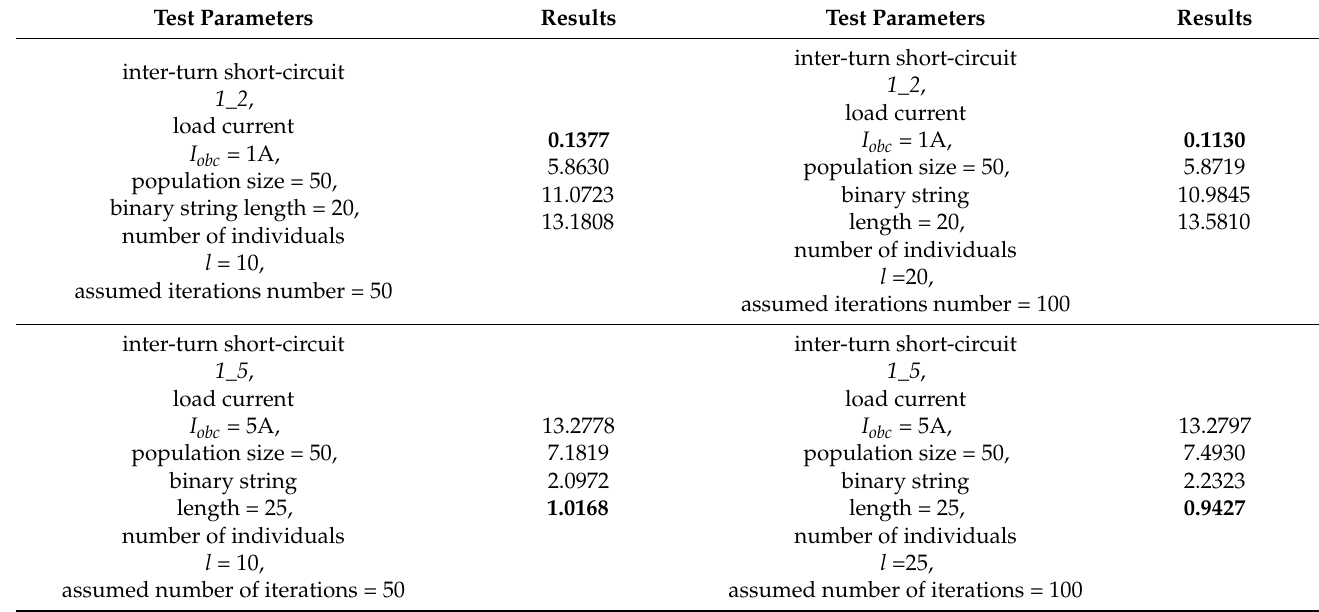
Table 4. Example results of matrix H 2 tests for acceleration signal in X axis— d x